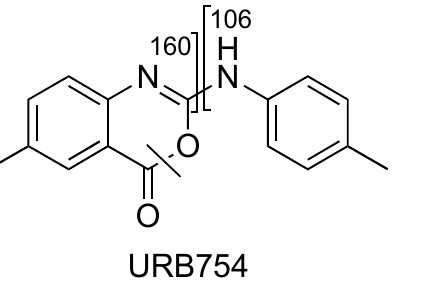
Figure 13 . Scan of URB602 compound obtained by HRMS.